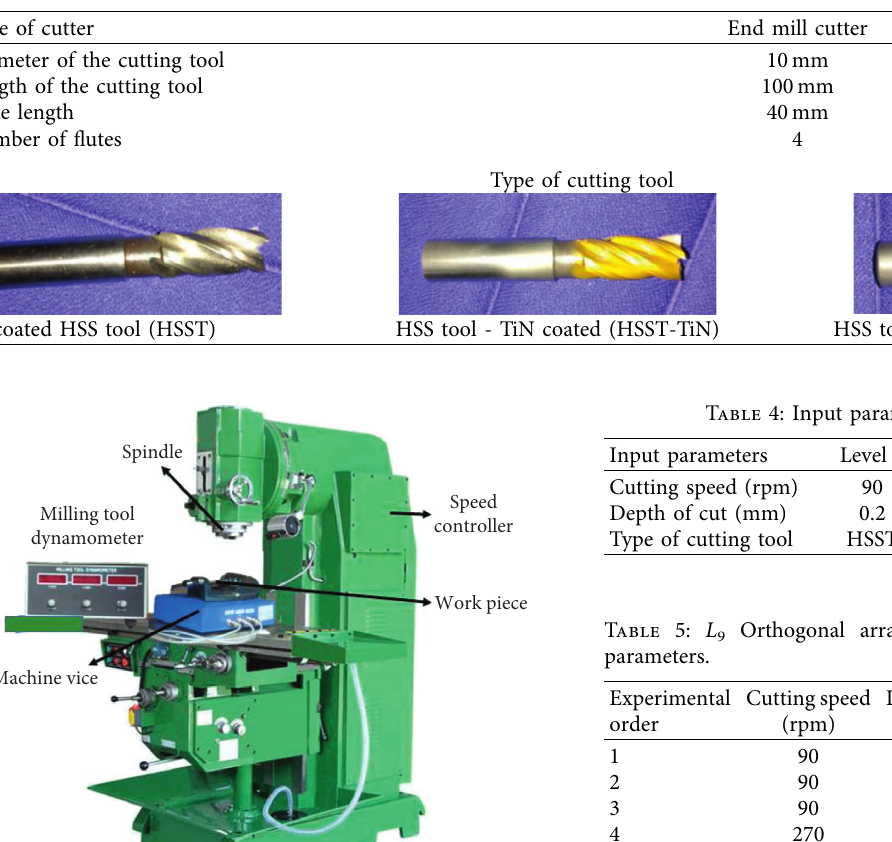
Table 3: Tool description of the HSS mill tool.